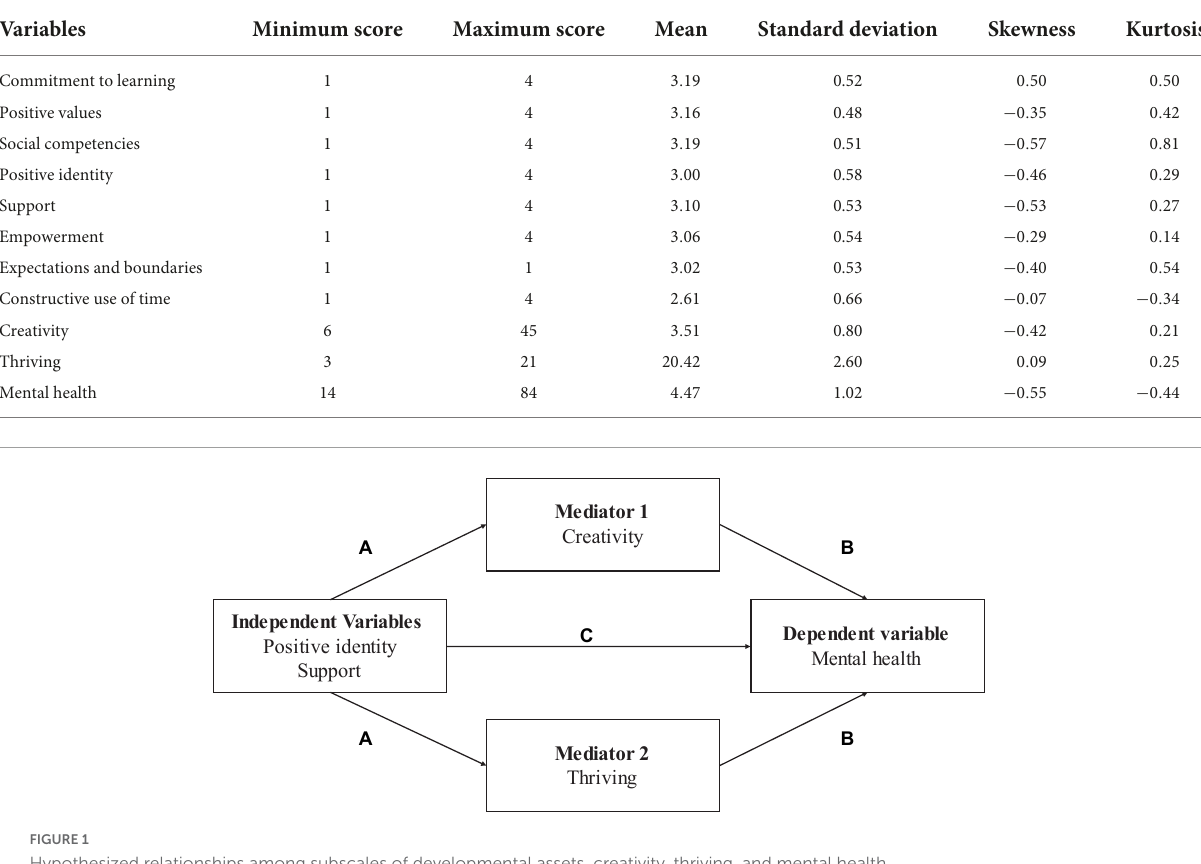
TABLE 2 Descriptive statistics of the study variables.